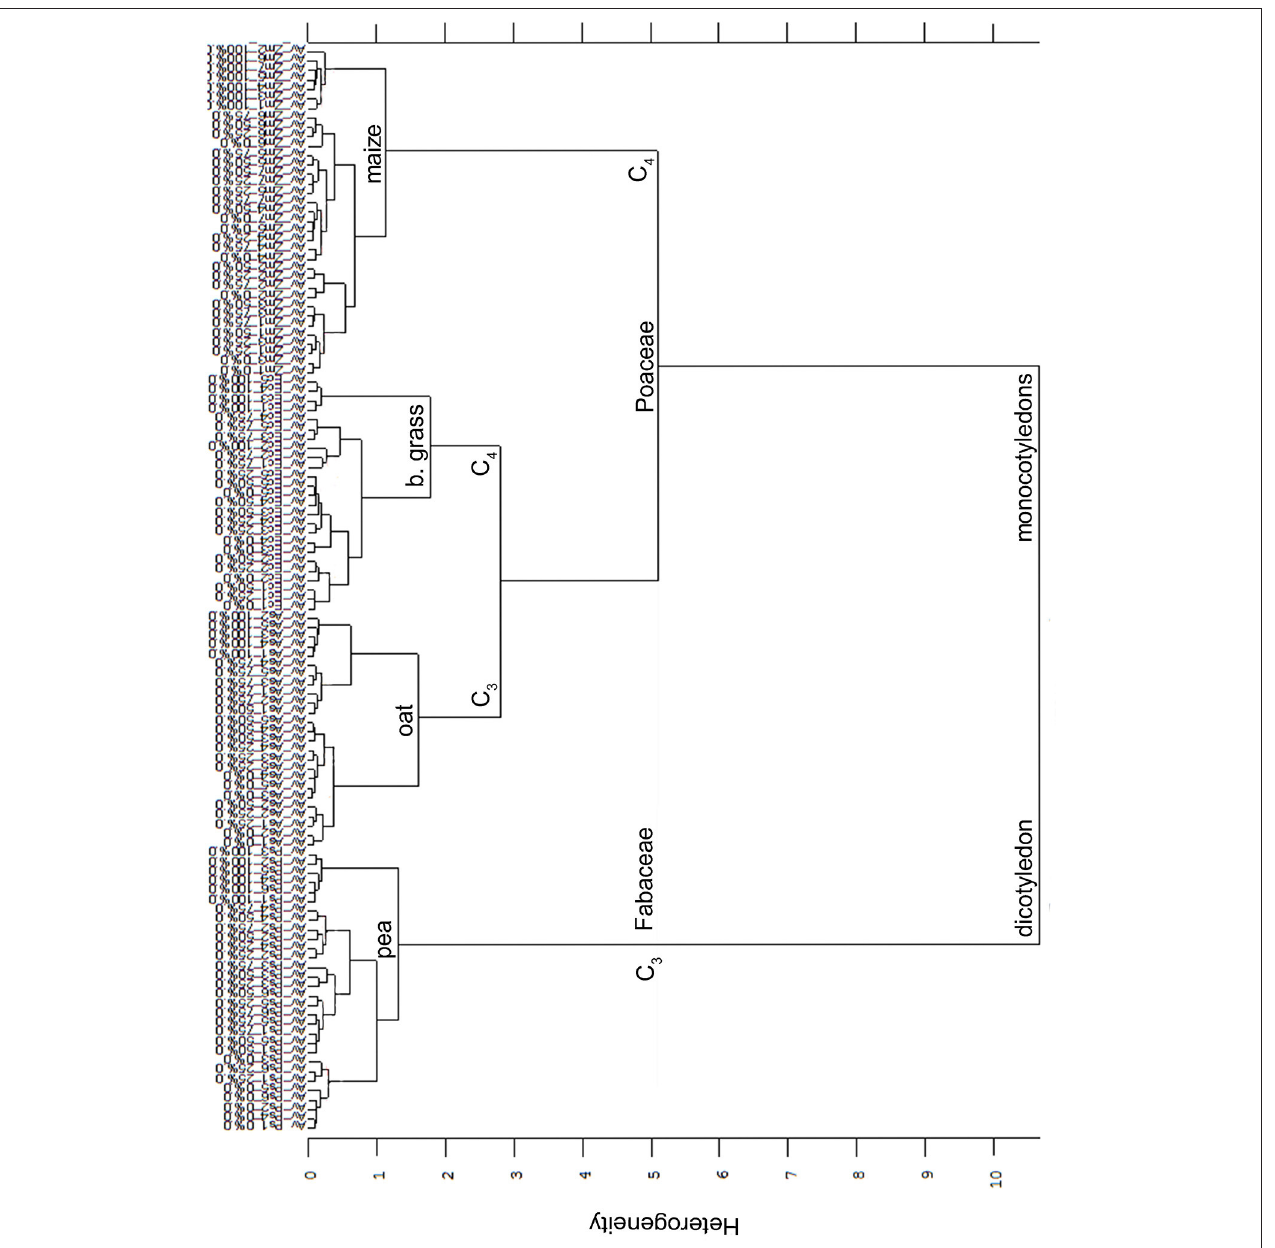
FIGURE 7 | Cluster analysis of the Av-spectra of all cultivars of the species Pisum sativum (Ps, pea), Avena sativa (As, oat), Zea mays (Zm, maize) and all proveniences of the species Echinochloa crus-galli (Ec, barnyard grass) for the united experiment 1 (exp. 1-1 and 1-2) as well as the united experiment 2 (exp. 2-1 and 2-2). Cluster analysis was evaluated with the first derivation and vector normalization of the reduced frequency range (3,751–2,749 cm − 1 and 1,801–599 cm − 1 ), Ward’s algorithm and Euclidian distance. The Av-spectra are averages (Av) of FTIR-ATR spectra of the different root segments (100% root tip, 0% root basis etc.; see Figure 1 for scheme, Table 2 for n, Table 1 for names of cultivars and